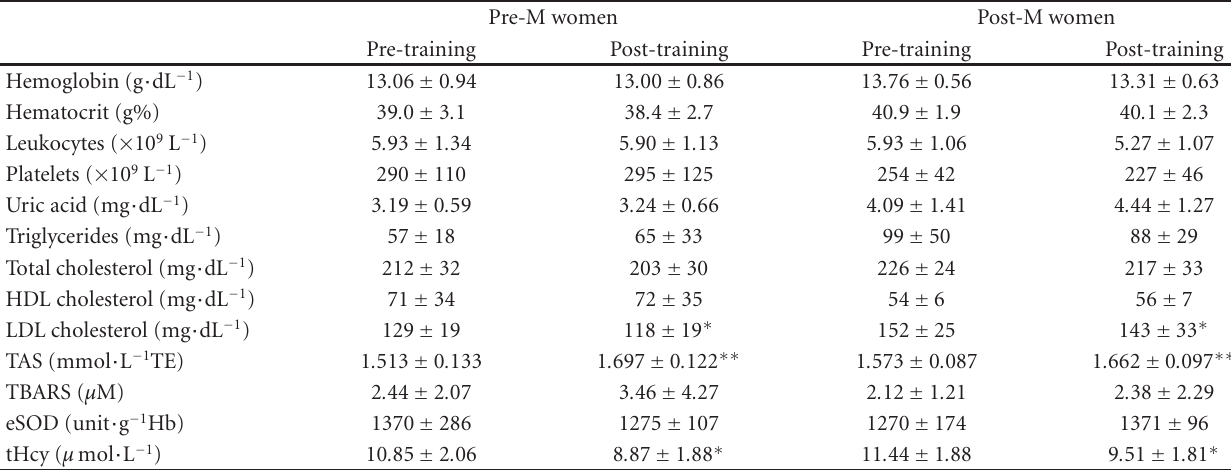
Table 3: Hematological and biochemical parameters of pre- and post-menopausal women before and after the Tai Chi training